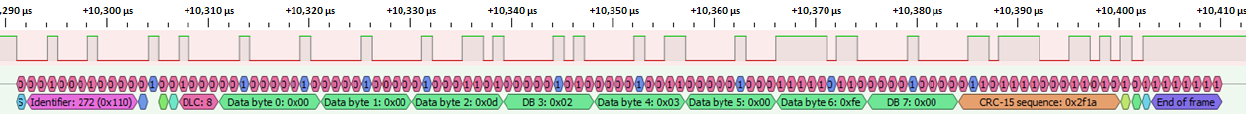
Figure 16. Detailed view of CAN message with ID